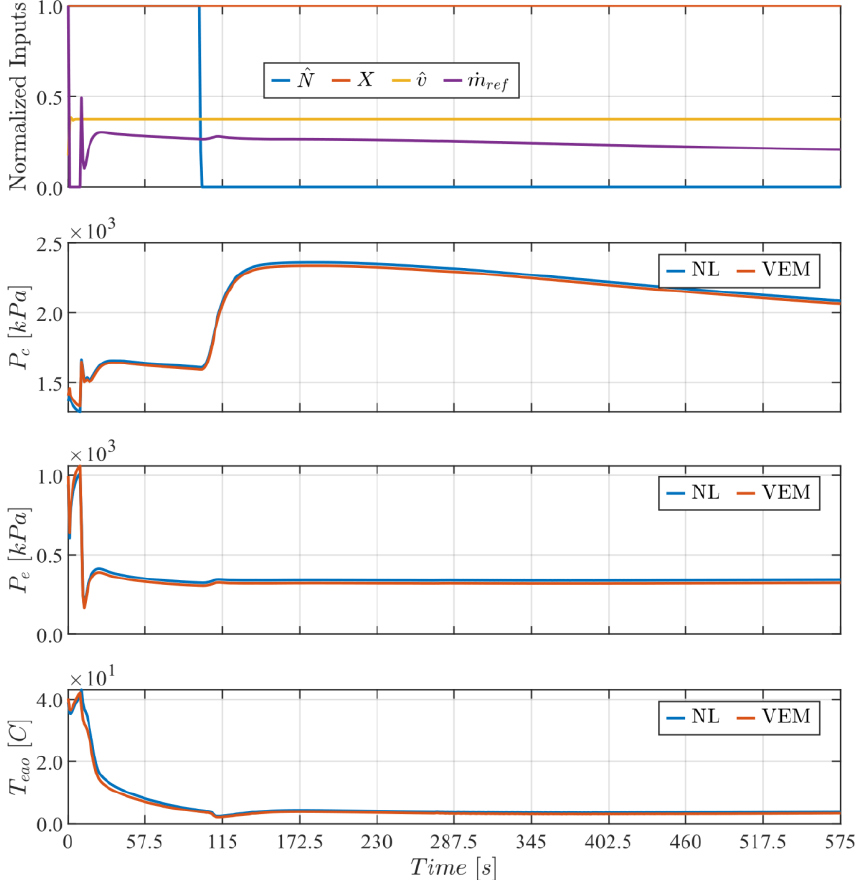
Figure 5. VEM and NL model comparison for fan speed step input — 2500 rpm to 0 rpm.